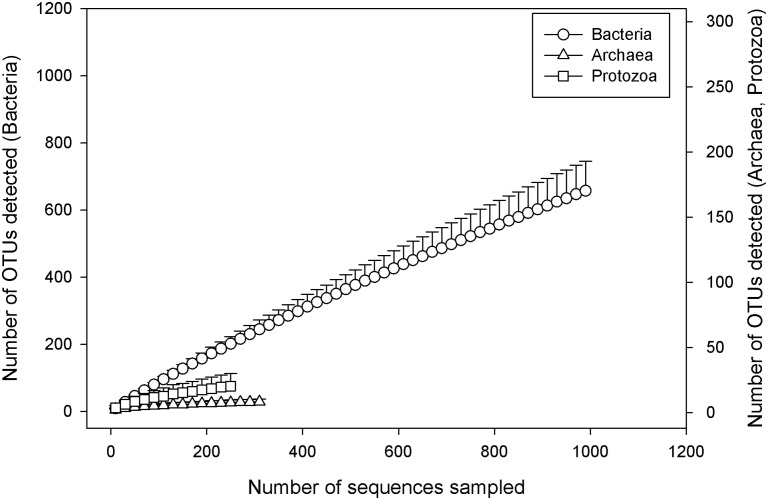
Rarefaction curves for microbial communities in faecal samples of forage-fed horses.The rarefaction curves show the mean number (with standard deviation) of observed species against the depth of sequencing of bacterial (-ο-), archaeal (-Δ-) and ciliate protozoal (--) communities in the equine faeces sampled in the study (n = 72 faecal samples). Multiple rarefactions were calculated from the OTU tables obtained for each of the three microbial groups representing 71 out of 72 samples for bacteria (minimum of 1,000 sequence reads/sample), 70 out of 72 samples for archaea (minimum of 320 sequence reads/sample) and 26 out of 37 samples for ciliate protozoa (minimum of 250 sequence reads/sample).